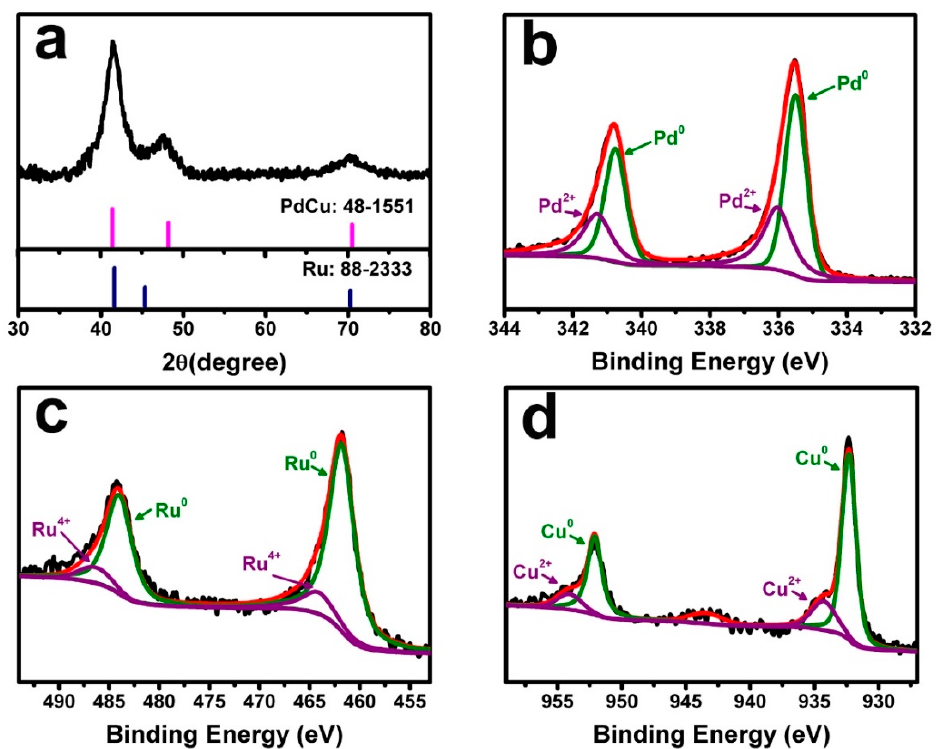
Figure 5. ( a ) XRD pattern, ( b ) high-resolution Pd 3d, ( c ) Ru 3p, and ( d ) Cu 2p XPS spectra of the Pd 24 Cu 29 Ru 47 nanoplates. Pd 24 Cu 29 Ru 47